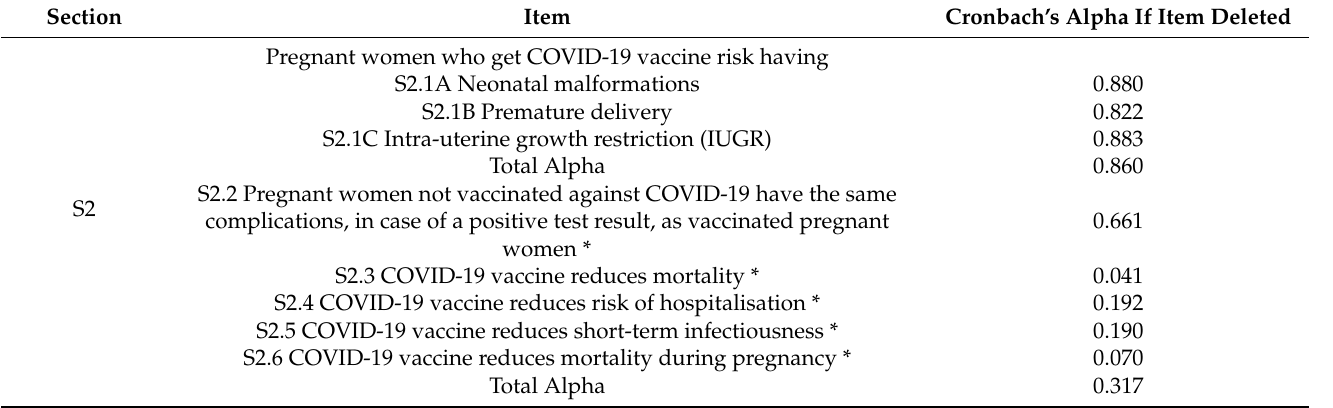
Table 2. Cronbach’s alpha analysis of the questionnaire stratified by